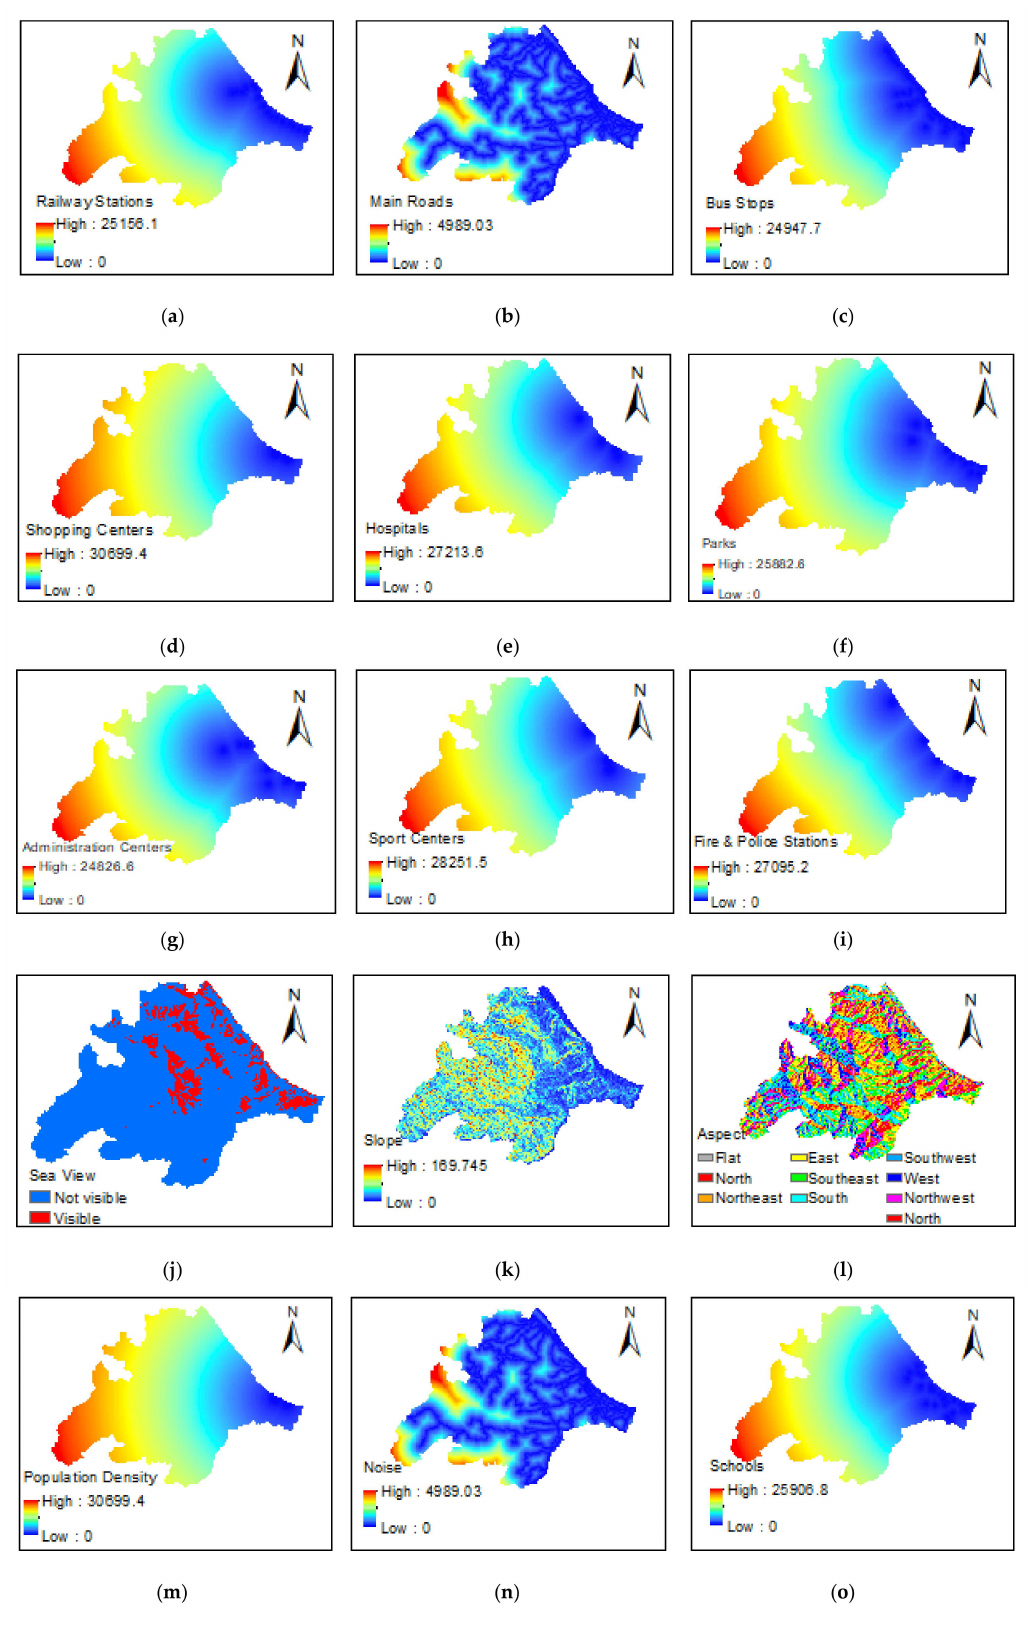
Figure 3. Criteria maps. ( a ) railway stations, ( b ) main roads, ( c ) bus stops, ( d ) shopping centers, ( e ) hospitals, ( f ) parks, ( g ) administration centers, ( h ) sport centers, ( i ) fire and police stations, ( j ) sea view, ( k ) slope, ( l ) aspect, ( m ) population density, ( n ) noise, and ( o )